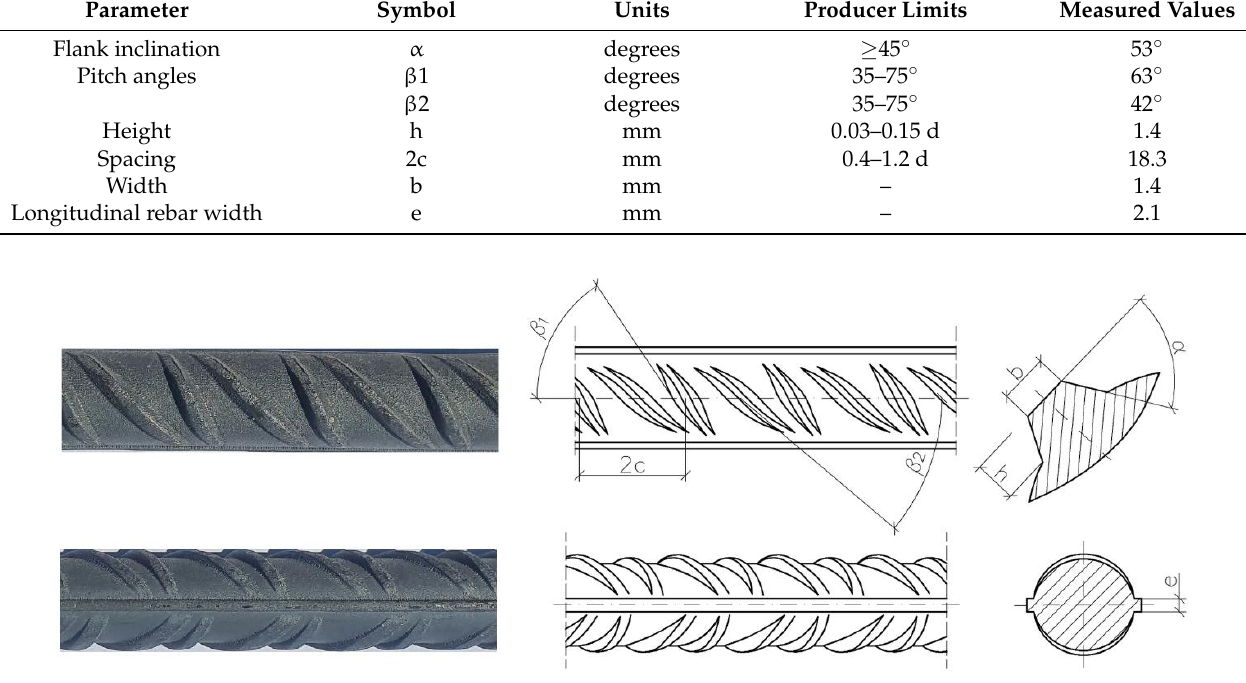
Figure 3. Geometry of B500SP reinforcing bars.